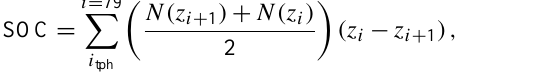
to a first approximation, the stratospheric vertical profiles of trace gases above the region of the nadir mode measurements of total columns. Integrating the coincident stratospheric pro- files from the tropopause upwards provides the stratospheric vertical column density above the target area. The subtraction of the stratospheric column amount from the total column measured in nadir yields the tropospheric column